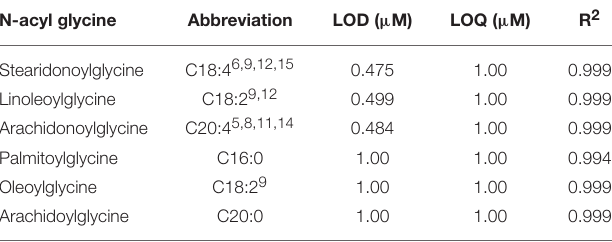
Calibrationcurveswerelinearbetween1and10 µ M.TheLODandLOQweredetermined by a S/N of 5 and 10, respectively.